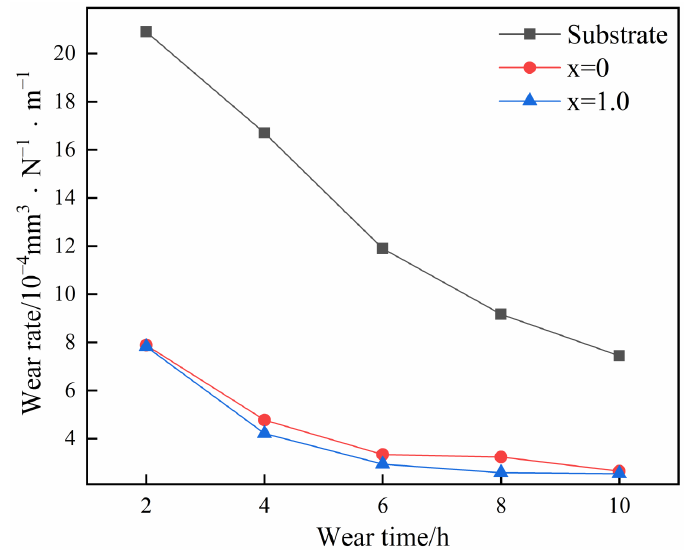
Figure 11. Change in wear rate of the samples with wear time. Figure 12 show the wear morphologies of the samples. The wear surface of the substrate subject to wear for 2 h is extremely rough (Figure 12(a1,a2)), and a large number of grooves (Zone A) parallel to the sliding direction can be clearly observed. The occurrence of these patterns is mostly attributed to the mechanical action from the counterpart. The sharp protrusions on the counterpart’s surface at the given load may produce the microcutting effect on the substrate, and the blunt protrusions may cause the plastic deformation of the substrate during the subsequent relative motion, leaving long and irregular groove-like patterns. Microcutting directly causes wear loss of the substrate. In addition, some irregular blocky substances with white edges can be observed as tightly adhering to the wear surface. These should be the debonding debris particles undergoing crushing. EDS was performed to analyze the chemical compositions in the two zones, i.e., Zones A and B in Figure 12(a2). Their chemical compositions are similar to those of the substrate (Table 5), demonstrating that the debris particles (Zone B) primarily originate from the debonding substrate. A small amount of O was detected in the two zones, indicating that they are partially oxidated during sliding. The O content in Zone B is higher than that in Zone A, and such finding is associated with the larger contact surface